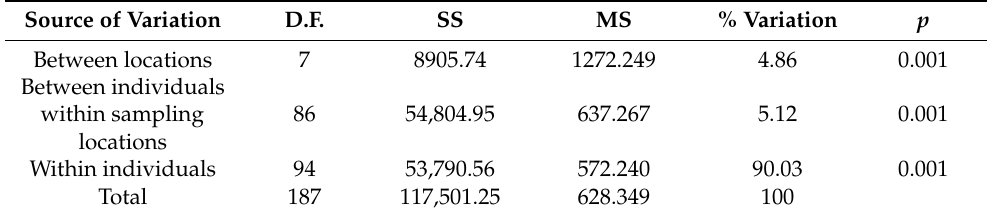
Table 2. Percentages of molecular variance within sugar glider individuals, between individuals within sampling locations, and between sampling locations.